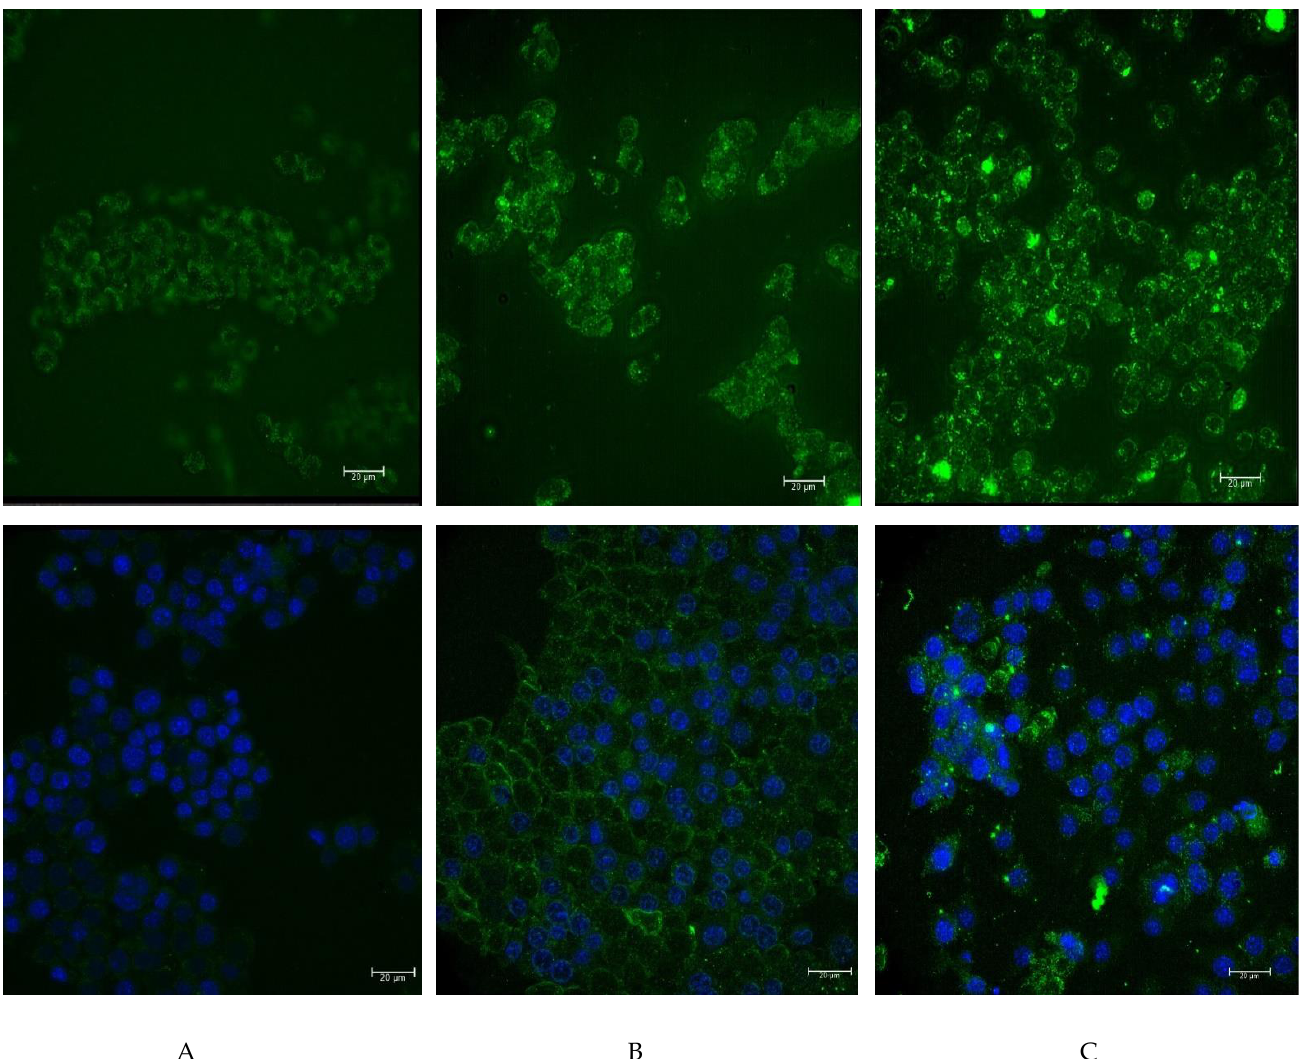
Figure 6. The interaction of RAW264.7 phagocytic cells with the boron carbide nanoparticles functionalized by coating with human IgG labeled with FITC. The microscopic image was obtained using the Leica THUNDER Imaging System. ( A ) The control RAW264.7 cells; ( B ) the RAW264.7 cells after 24 h incubation with FITC-labeled human IgG; ( C ) the RAW264.7 cells after 24 h incubation with the boron carbide particles coated with the FITC-labeled human IgG. The top line shows the control cells and cells after incubation with boron nanoparticles containing FITC-labeled antibodies. The lower line shows the paraformaldehyde-fixed cell preparations with the nuclei additionally stained using DAPI (scalebars 20 µm).